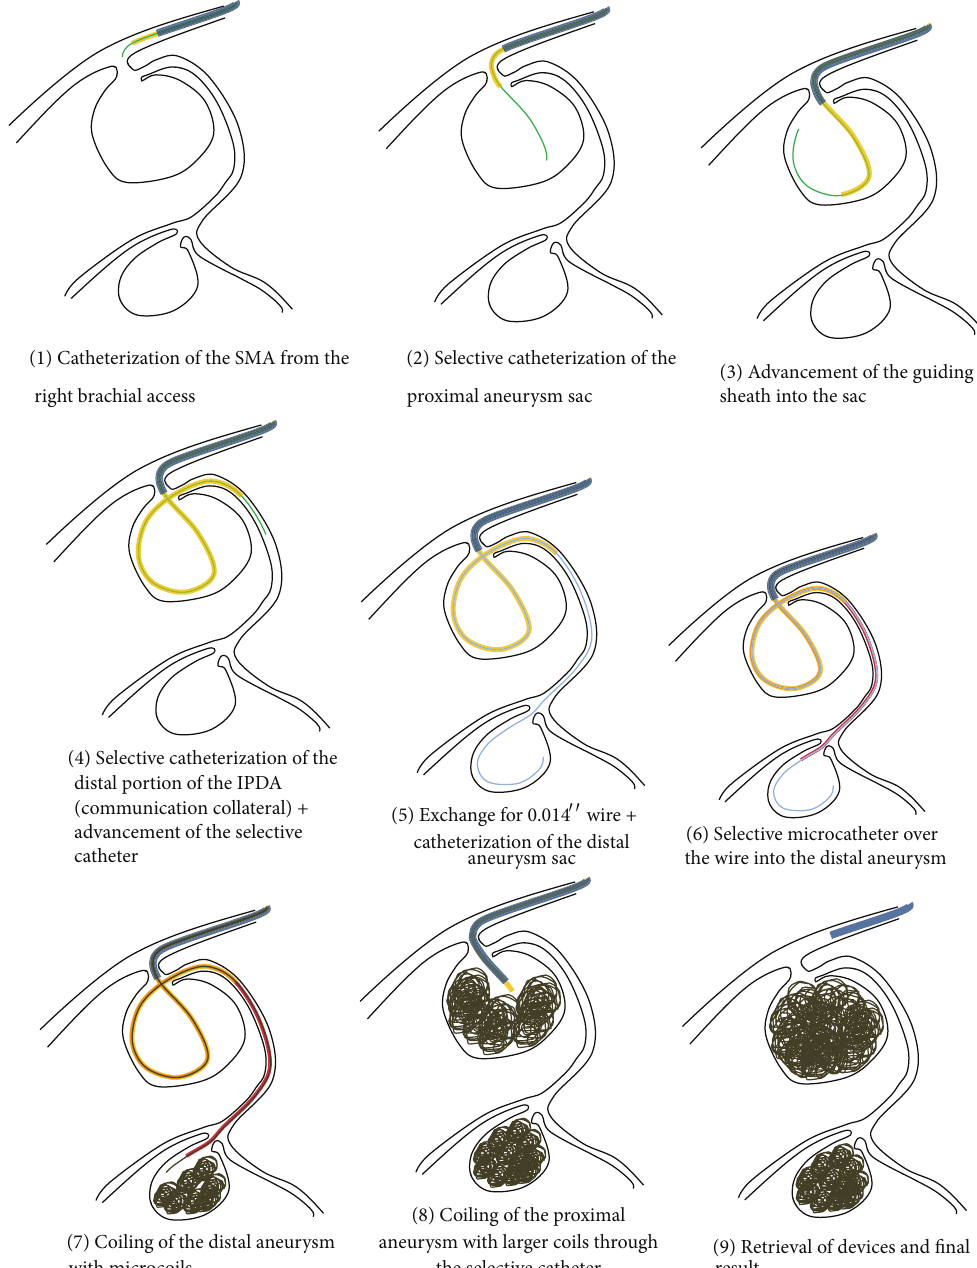
Figure 2: Diagram demonstrating the steps of the procedure. SMA: superior mesenteric artery, colors—blue: guiding sheath, yellow: selective catheter, green: 0.035 󸀠󸀠 hydrophilic guidewire, red: microcatheter, Cyan: 0.014 󸀠󸀠 guidewire, olive gray: coils.